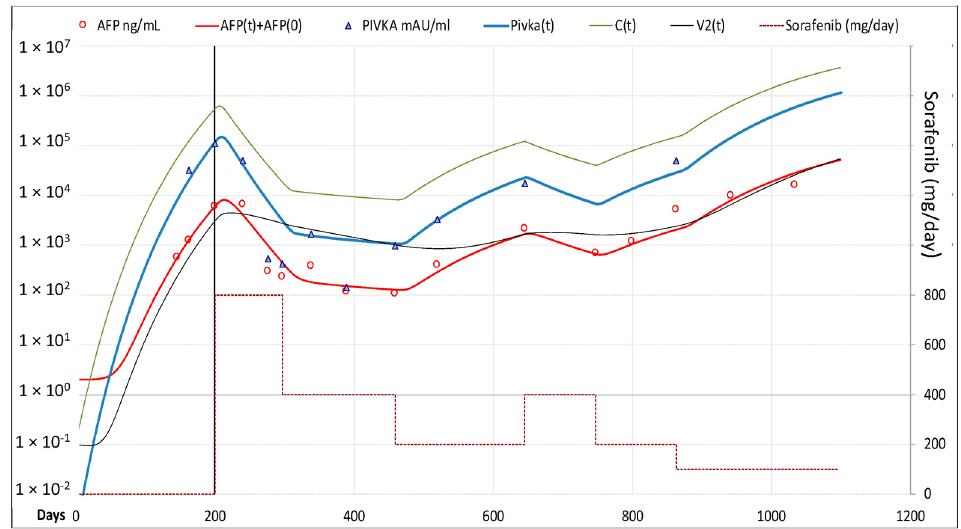
Figure 4. Best fitting of AFP and PIVKA-II serum levels in Case-2. AFP and PIVKA-II levels showed fluctuations correlated to C(t) and to the dose of sorafenib. Legend : AFP = measured AFP; AFP(t) = model computed AFP; AFP(0) = AFP normal value; PIVKA-II = measured PIVKA-II; Pivka(t) = computed PIVKA-II; C(t) = model computed cancer cells; V2(t) = model computed vascularization